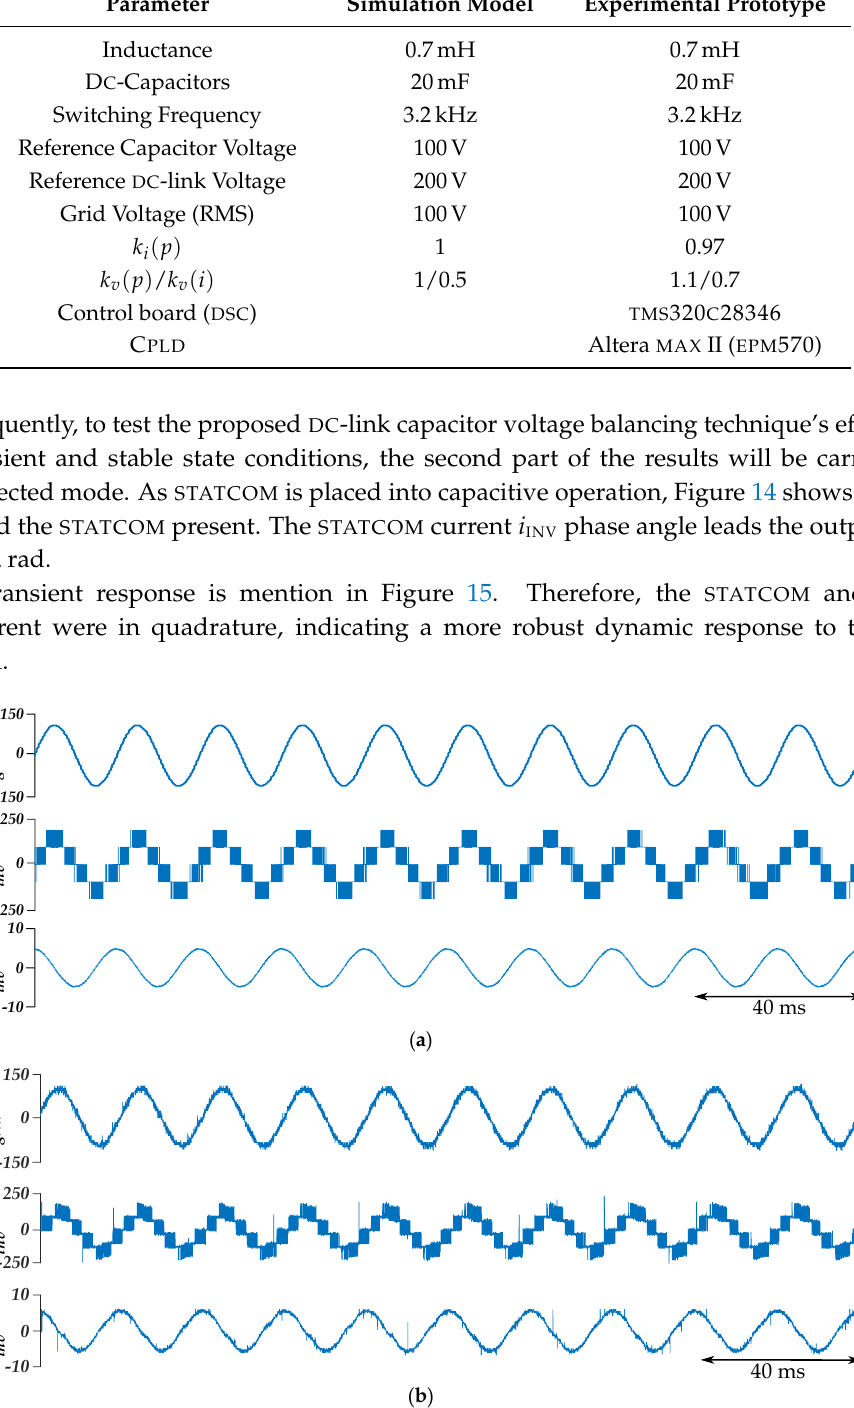
Figure 14. Closed loop steady state waveforms of CCHB - MLI . ( a ) Simulated waveforms. ( b ) Experimental